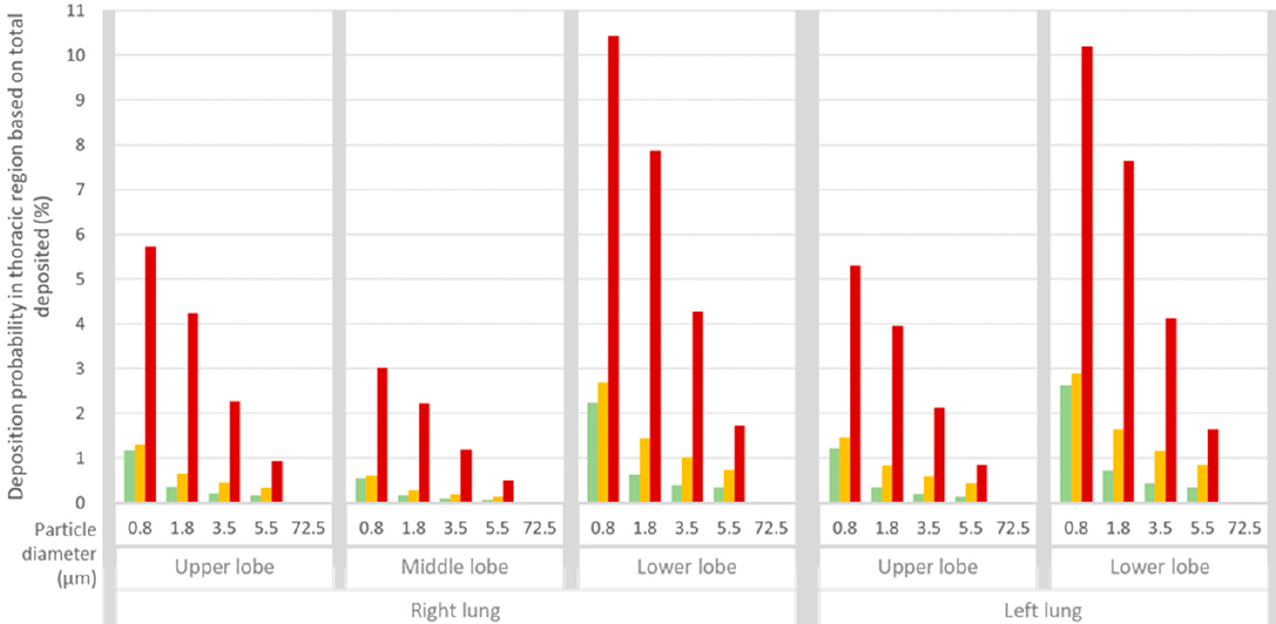
Figure 5. Deposition probability of ARAPs in the thoracic region, based on total deposited particle number (extrathoracic, thoracic). Deposition probability is shown for all five ARAP modes and is dissected further to the thoracic regions of the bronchial region (BB, green), bronchiolar region (bb, yellow) and alveolar-interstitial region (AI, red) for each lobe.